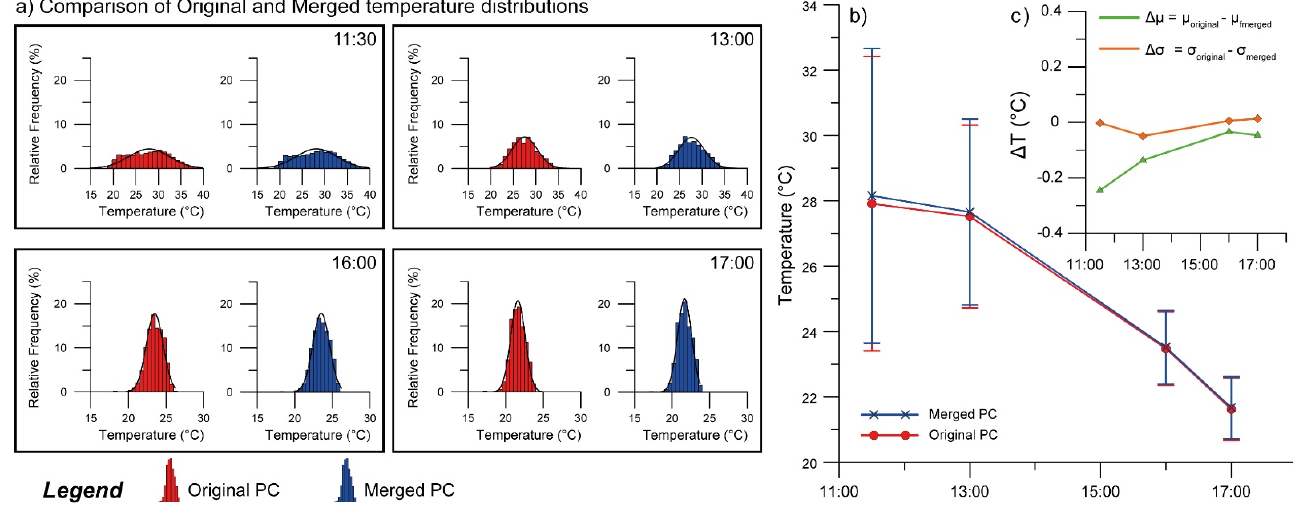
Figure 7. ( a ) Temperature distributions derived from original (red bars) and merged point clouds (blue bars). ( b ) Comparison between mean temperature values and standard deviations of original and merged point clouds. The high grade of correspondence between derived values is also highlighted, both in terms of central tendency and dispersion values, by the computation of the absolute difference in mean ( Δμ ) and standard deviation ( Δσ ) values for each original and merged point cloud ( c ).